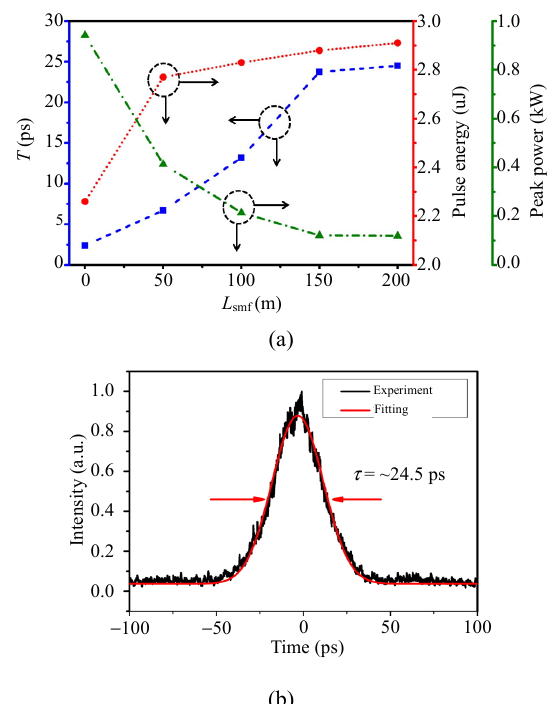
Fig. 6 Pulse characteristics after EDFA: (a) pulse width (blue curve), pulse energy (red curve), and peak power (green curve) varying with the access length of the SMF after the pulse amplification and (b) autocorrelation trace fitted by the Gauss-shaped pulse after EDFA when L smf is 200 m.